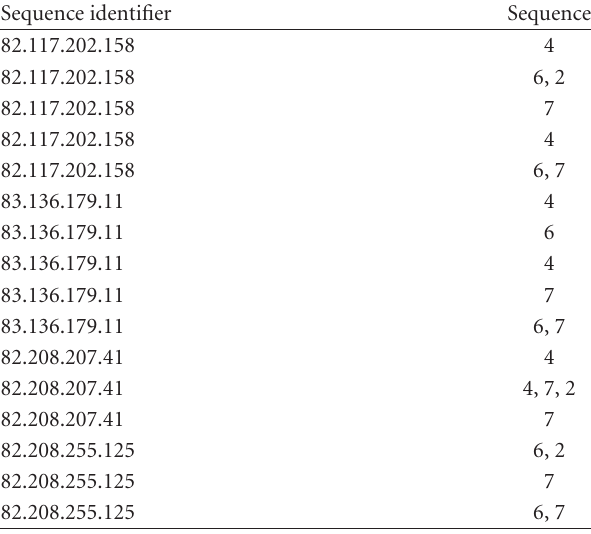
Table 5: Sequence set.